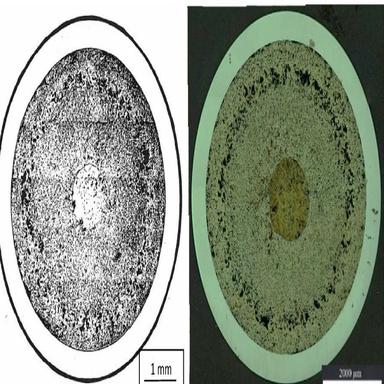
X501-G582 cross section optical image x/L ¼ 0.3 (left hand side) compared to X501-G591 x/L ¼ 0.27 (right hand side), local burnup 6.14% FIMA.